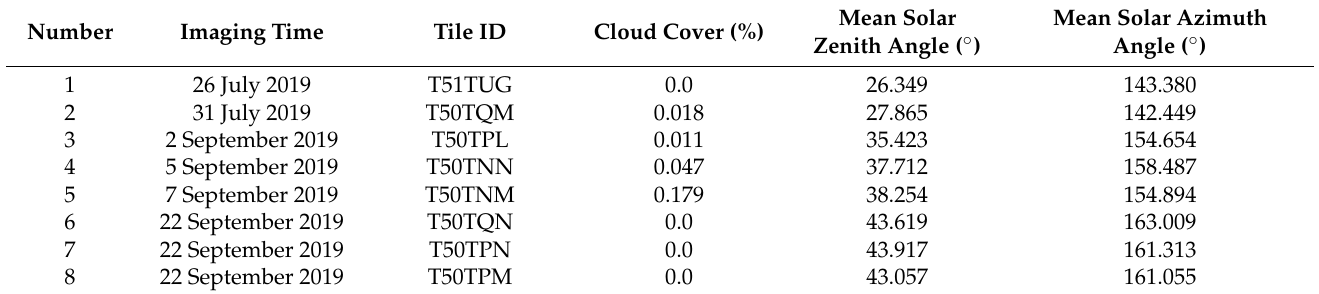
Table 2. Parameter information for Sentinel-2 remote sensing images of the study